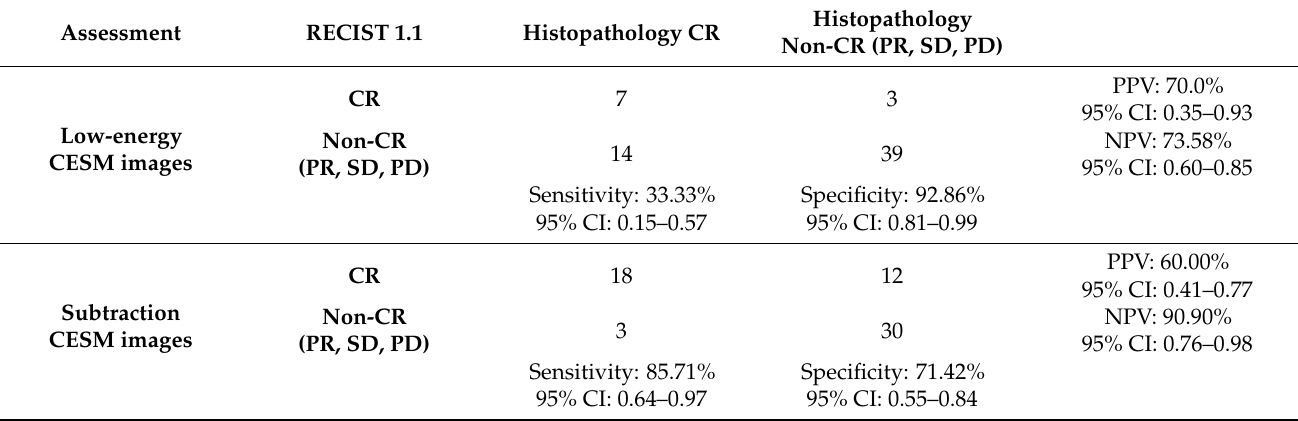
Table 5. Diagnostic performance indexes for the assessment of complete (CR) and non-complete response (PR, SD, PD) according to RECIST 1.1criteria using low-energy and subtraction CESM images compared to histopathology results.